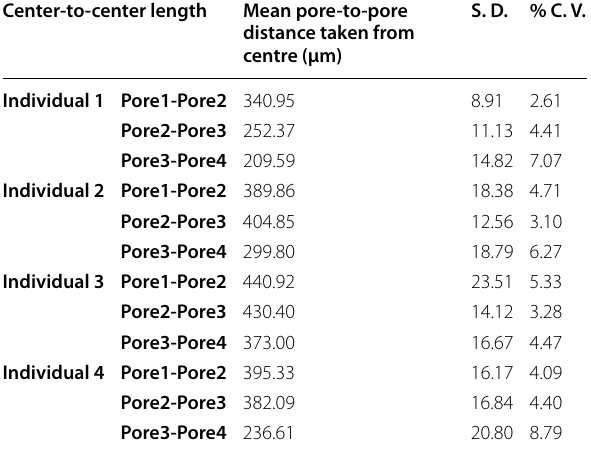
Individual 3 Pore1‑Pore2 440.92